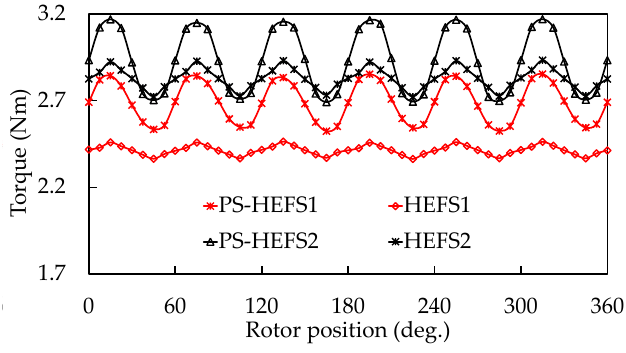
Figure 15. Predicted torque waveforms.